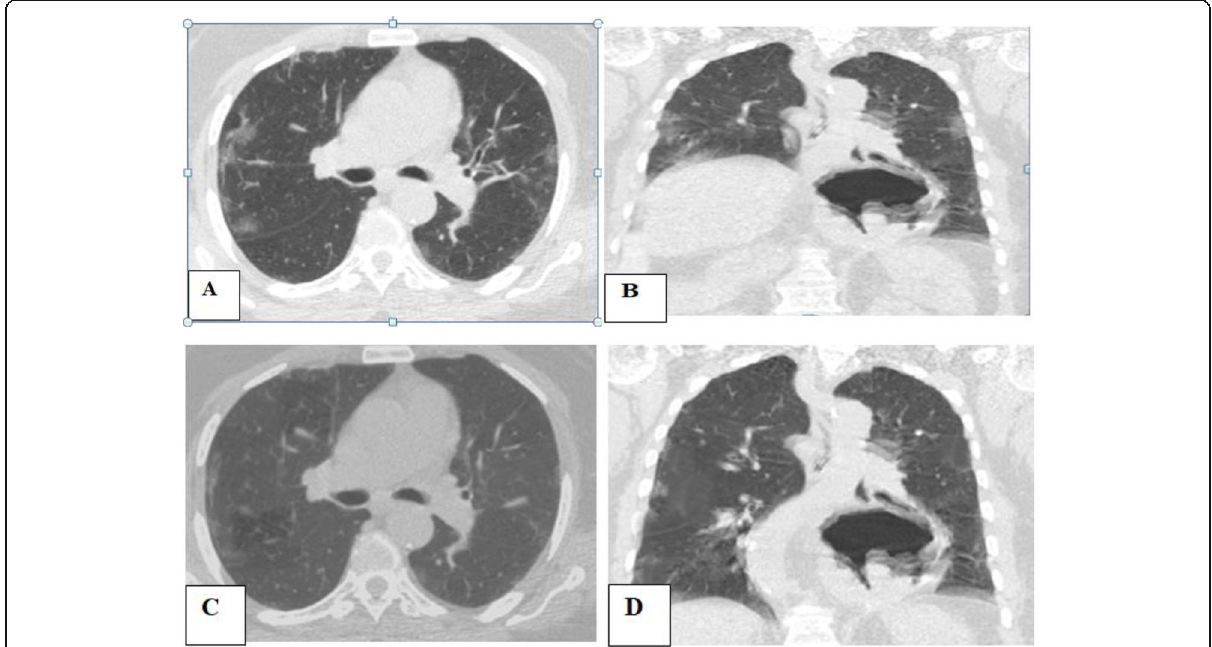
Fig. 2 Fifty-one-year-old male patient, with a history of COVID-19 pneumonia, referred for initial CT evaluation with CT severity score 8. A , B Axial and coronal CT chest imaging respectively shows bilateral sub-pleural ground-glass patches and pulmonary consolidation with interlobar septal thickening. Incidental discovery of right-sided diaphragmatic paralysis. A notice of large axial hiatus hernia. C , D Images after 4 weeks reveals remarkable regression of bilateral patchy ground glassing and consolidation with resolution of the previous right phrenic